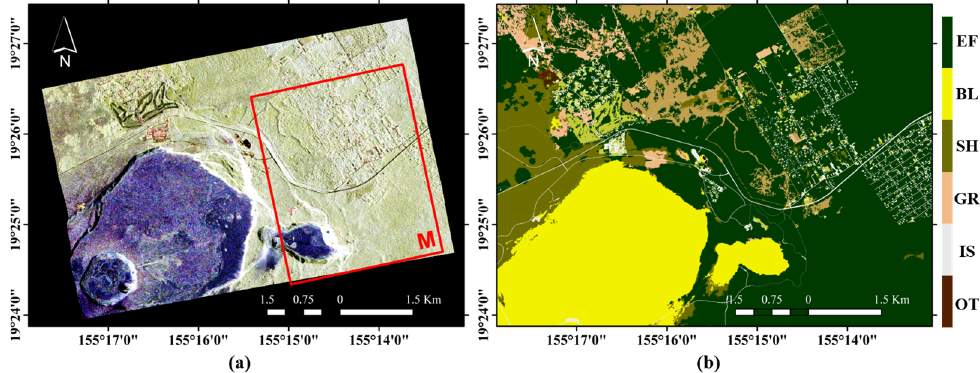
Figure 6. ( a ) PauliRGB image of the study area in Kilauea Volcano (Hawaii) formed by the average intensities. (Channels: R = HH − VV, G = 2 × HV, B = HH + VV) ( b ) Landcover map from NOAA in 2010. (EF: evergreen forest; BL: bare land; SH: shrub; GR: grassland; IS: impervious surface; OT: